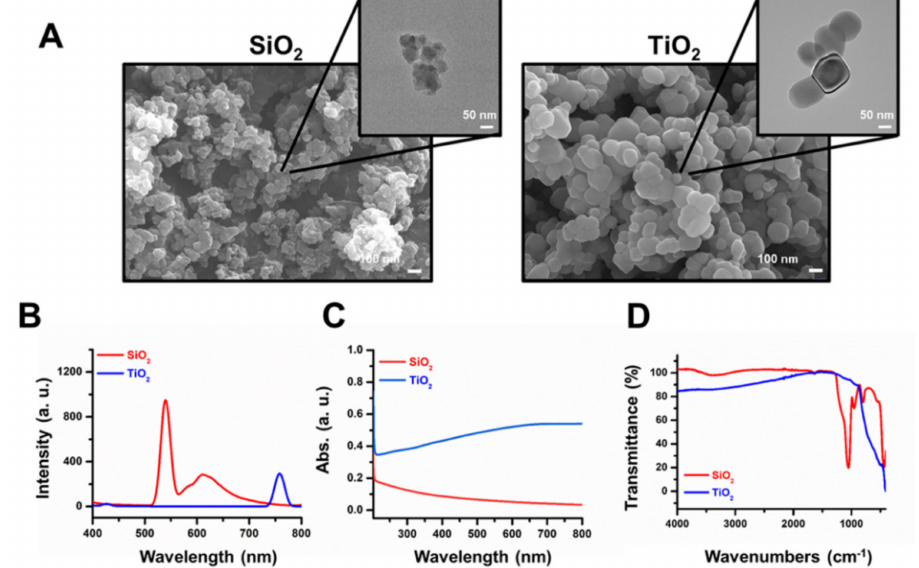
Figure 1. Characterization of the sterilized SiO 2 and TiO 2 nanoparticles. ( A ) Scanned electron microscopy (SEM) and transmission electron microscopy (TEM, small picture) images of the SiO 2 and TiO 2 nanoparticles. ( B ) PL (1 µ M solubilized in ethanol). ( C ) Ultraviolet–visible absorbance spectra (1 mM solubilized in ethanol) and ( D ) Fourier-transform infrared spectra of the SiO 2 and TiO 2